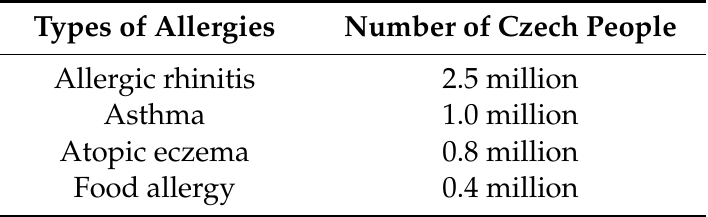
Table 2. Allergies in the Czech Republic